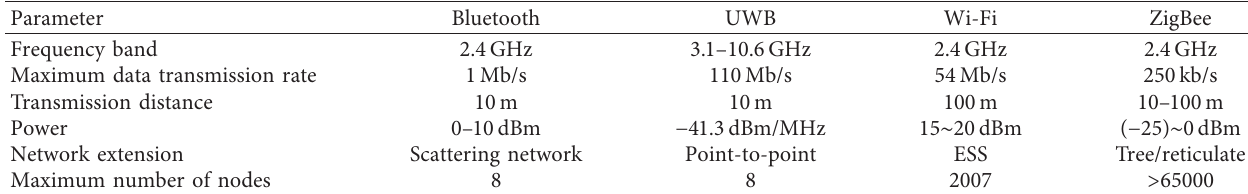
Figure 5: WSN transmission Table 3: Comparative analysis of communication technologies.